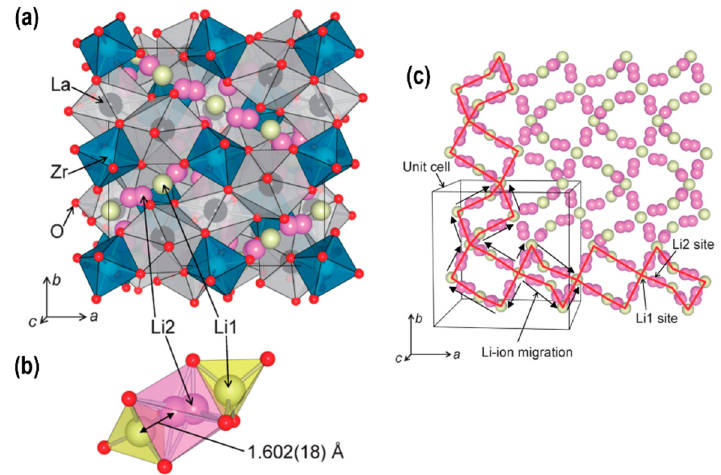
Figure 6. Crystal structure of ( a ) cubic Li 7 La 3 Zr 2 O 12 (LLZO), ( b ) coordination polyhedra around the Li1 and Li2 sites and ( c ) Li + migration through the LLZO crystal structure. Reprinted from ref. [216] with permission of The Chemical Society of Japan.